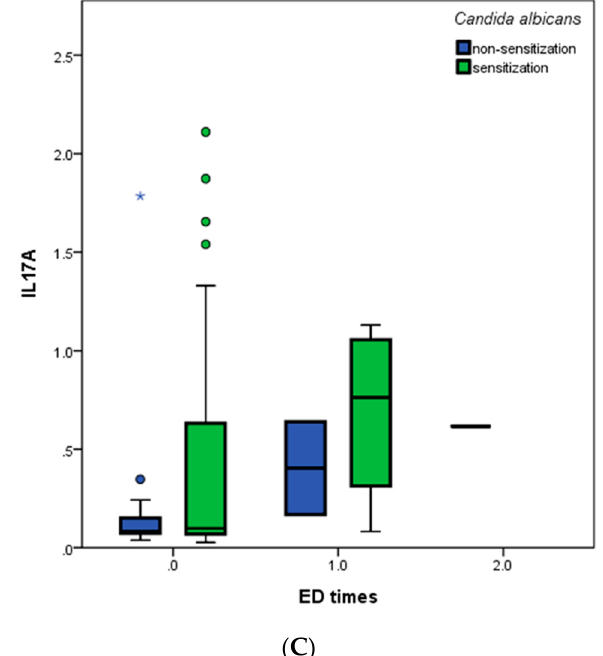
Figure 3. Comparing IL-17A levels in asthmatic patients with fungal sensitization and non- sensitization grouped by ED visit times. Botrytis cinerea ( A ); Saccharomyces ( B ); Candida albicans ( C ). * p < 0.05.